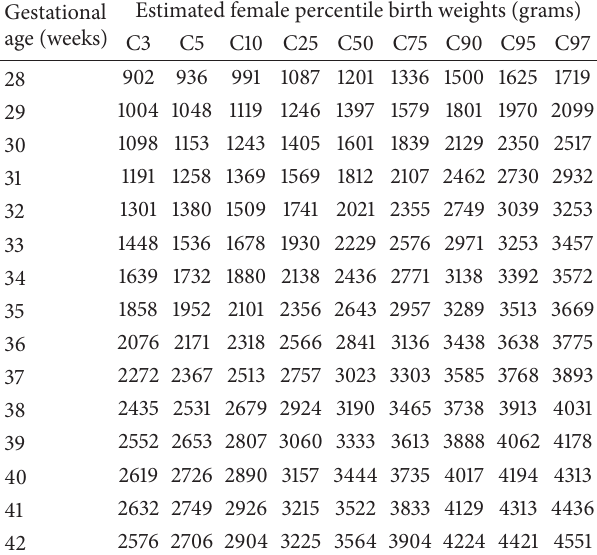
Table 4: Estimated birth weight percentiles for gestational age for female Cameroonian